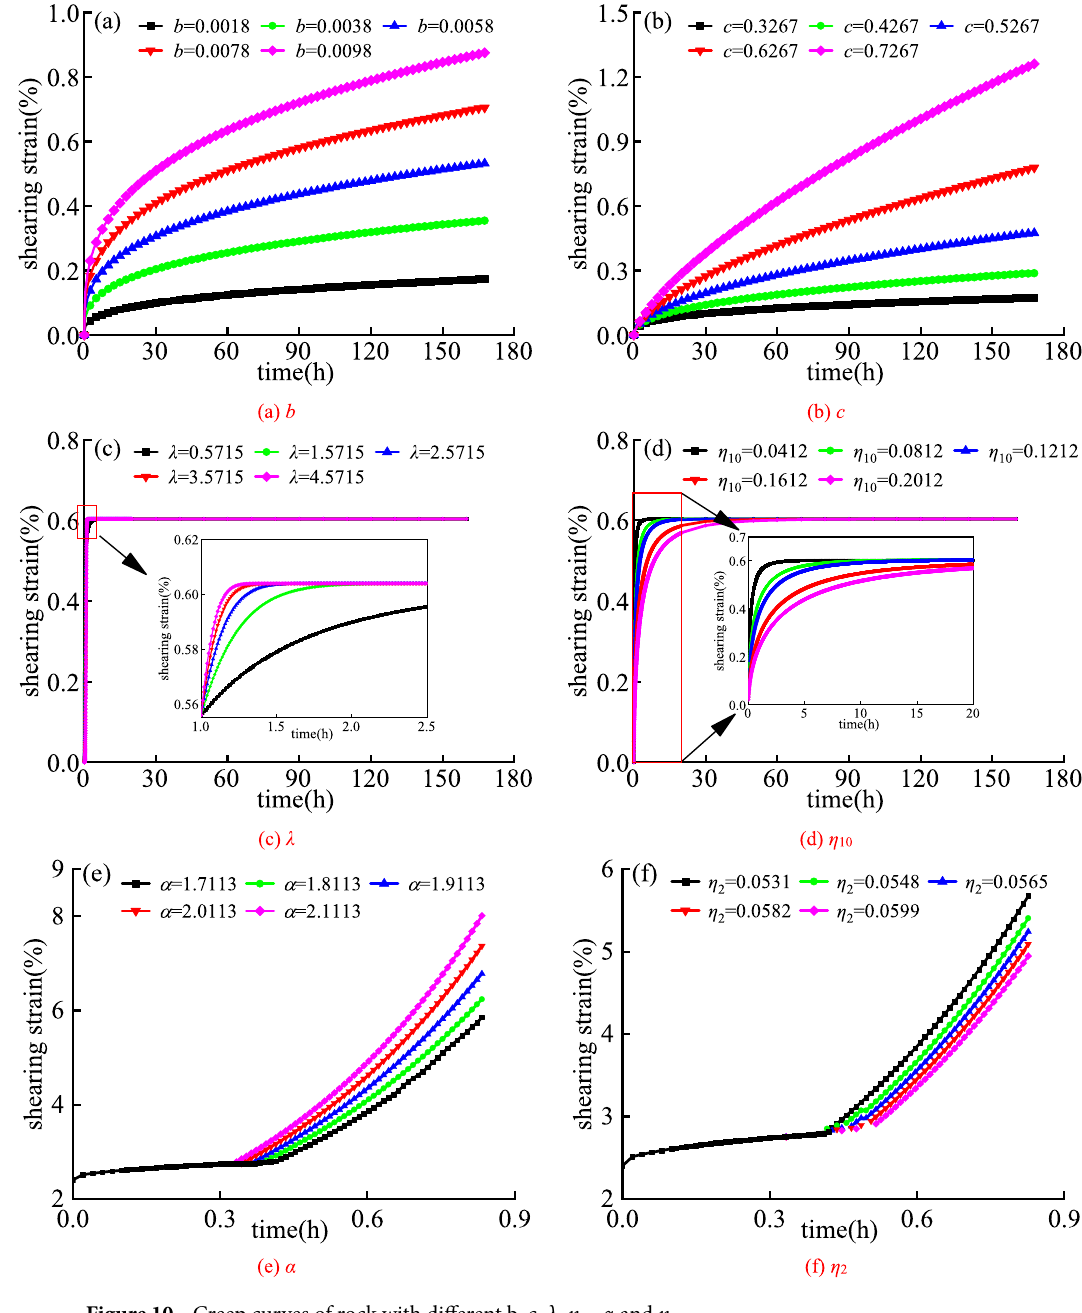
Figure 10. Creep curves of rock with different b, c, λ , η 10 , α and η 2